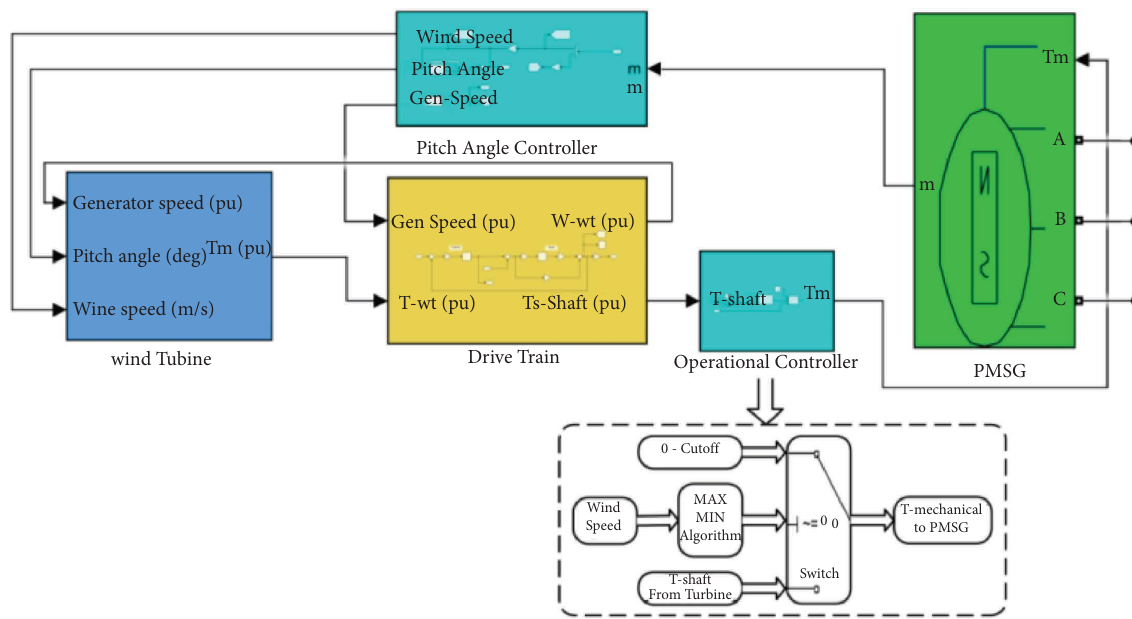
Figure 7: Te operational control scheme of the WECS. Table 5: LCL flter parameters used in the design.